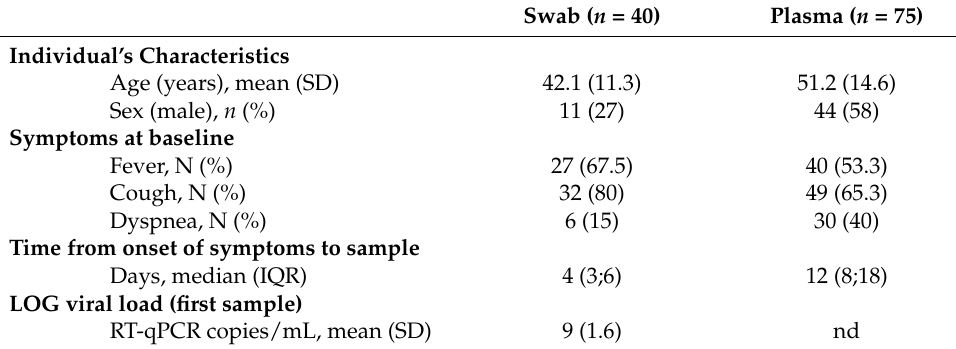
Table 1. Baseline characteristics of index